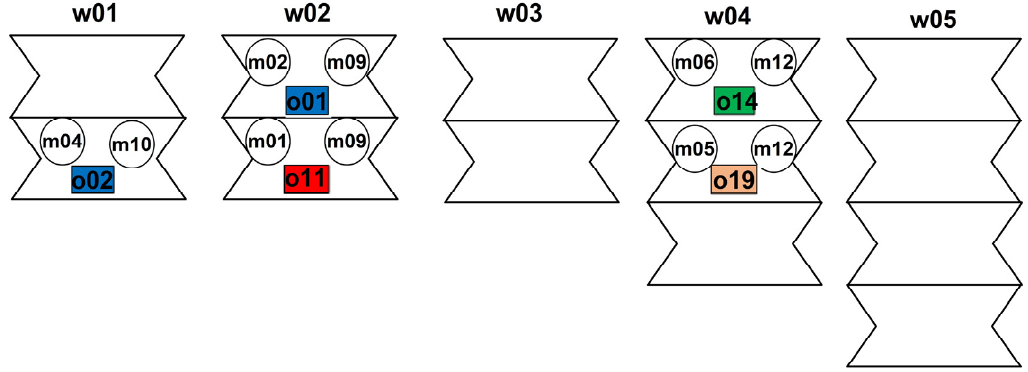
Figure 6. System configuration for a moment of time τ = 2 (concerns question Q _ 1 ).